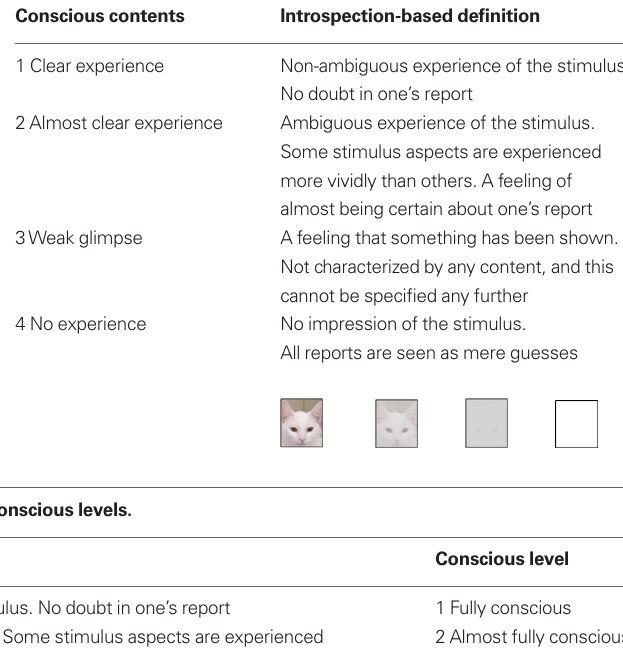
Table 1 | The response categories, created by participants in the Ramsøy and Overgaard (2004) experiment. The figures below intend to illustrate how the categories refer to a still “less clear” image. According to the subjects’ own reports, and consistent with the behavioral results, a “lower degree” of conscious content is experienced as being overall more “blurry” and/or vague (e.g., Overgaard et al.,